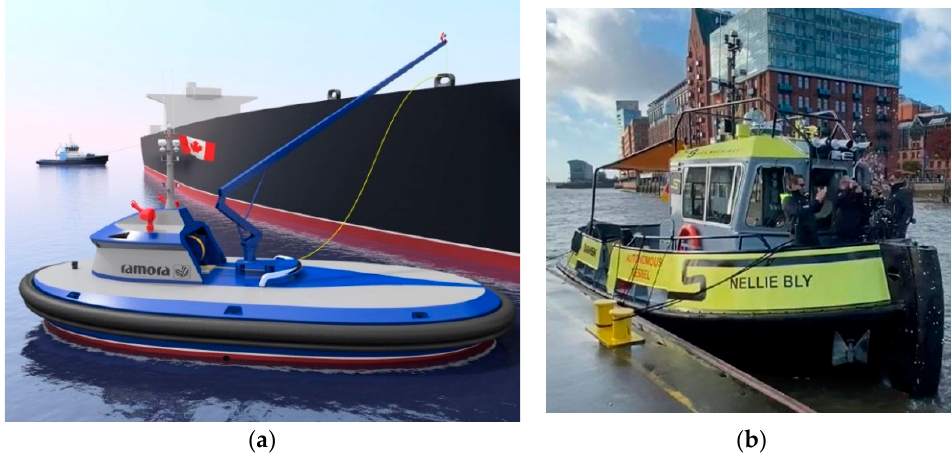
Figure 1. Tugboat RAmora designed by Robert Allan Ltd. [1] ( a ), and Tugboat Nellie Bly, demonstrator of the SM300 navigation system ( b ) [2].